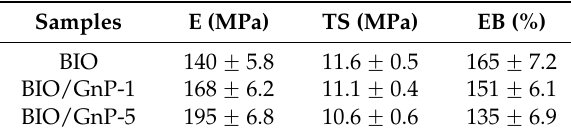
Table 2. Elastic modulus (E), tensile strength (TS), and elongation at break (EB) of neat BIO and related nanocomposites.